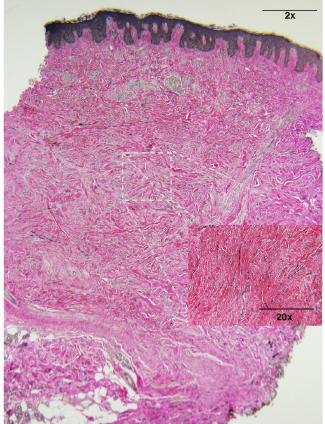
Figure 3: A tissue elastic stain shows preserved elastic fibers within areas of scleroderma. In areas of keloid these elastic fibers are typically absent, thus supporting the diagnosis of keloidal scleroderma and not that of a